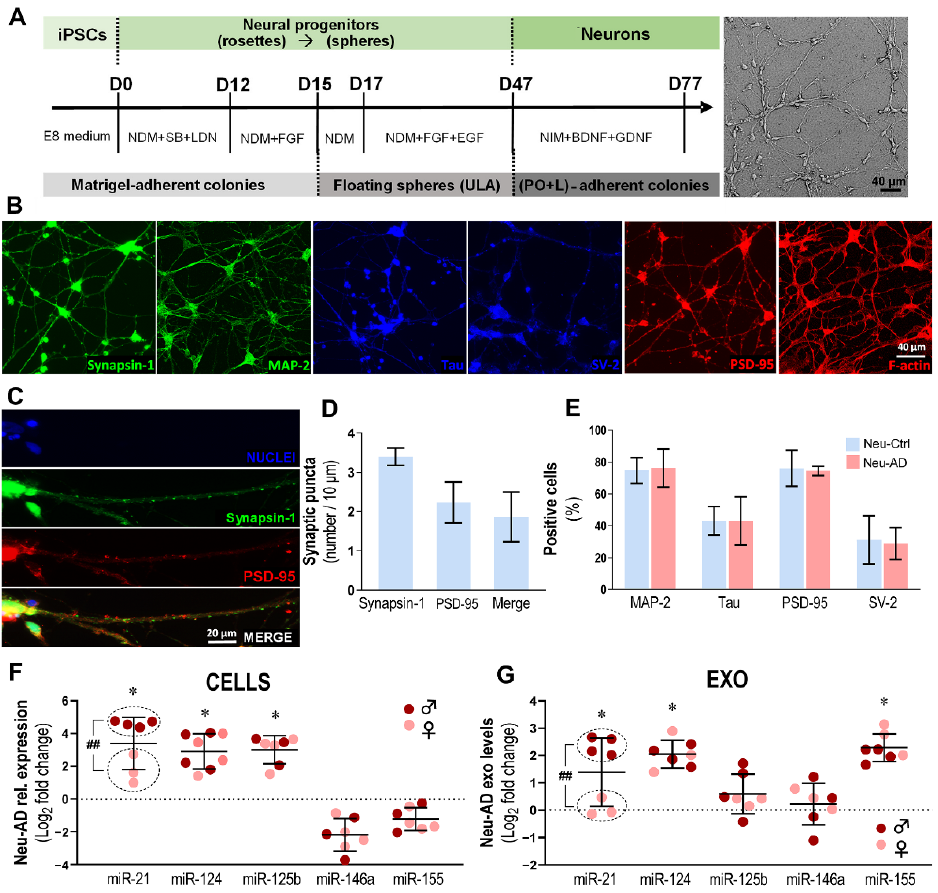
Figure 5. Characterization reveals successfully differentiated and maturated neurons, while Neu-AD cell lines show alterations in intracellular and exosomal miRNAs, which include the simultaneous elevation of miR-21 and miR-124. ( A ) Schematic representation of iPSC differentiation into induced neurons (Neu), as detailed in Materials and Methods. ( B ) iPSC-derived neurons express the typical neuronal markers synapsin-1, MAP-2, Tau, SV-2, PSD-95 and F-actin. ( C ) Representative images of synaptic puncta in neurons, with co-localization of synapsin-1 and PSD-95, and ( D ) quantification of individual and double-labeled puncta. Nuclei were counterstained with Hoechst. ( E ) Comparative number of cells expressing MAP-2, Tau, PSD-95 and SV-2 protein markers in neurons from AD and Ctrl donors. ( F ) Quantification of the selected inflamma-miRNAs in Neu-AD cell lines and ( G ) in their derived exosomes expressed as the binary logarithm of fold change vs. Neu-Ctrl cells (dotted line). Samples from a male patient (in blue dots) and a female patient (in pink dots) were distinguished. Scale bars correspond to 40 µm in ( A ) and ( B ) and to 20 µm in ( C ). Results are mean ± SEM from at least 7 independent experiments. Two-tailed Student’s t -test: * p < 0.05, Neu-AD vs. Neu-Ctrl; ## p < 0.01, male (n = 4) vs . female (n = 3) samples. Neu, iPSC-induced neurons; AD, Alzheimer’s disease; Ctrl, control; EXO, exosomes. SV-2, synaptic vesicle protein 2; PSD-95, postsynaptic density protein; MAP-2, microtubule-associated protein-2; F-actin, filamentous actin; NDM, neural differentiation media; LDN, LDN193189 dihydrochloride; SB, SB431542; FGF, fibroblast growth factor; EGF, epidermal growth factor; NIM, neural induction media; BDNF, brain-derived neurotrophic factor; GDNF, glial-cell-derived neurotrophic factor; ULA, ultra-low-attachment plates; PO, poly-L-ornithine; L, laminin; D, day.